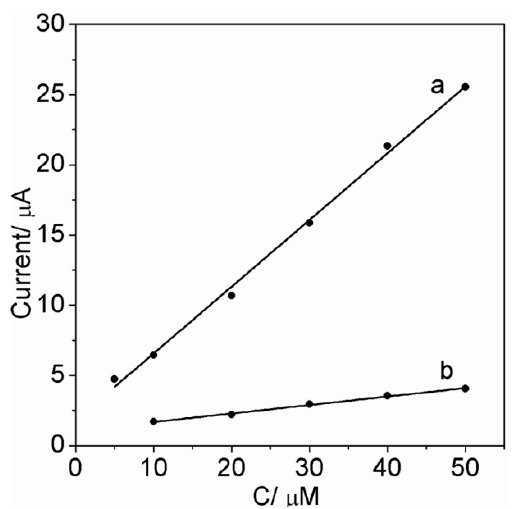
Figure 6. Calibration curves corresponding to the analysis of PO (curve a) and PT (curve b) by the imprinted PATP/AuNPs/SPCE. All data were recorded after interacting the respective electrode with the PO or PT solution sample for 10 min.